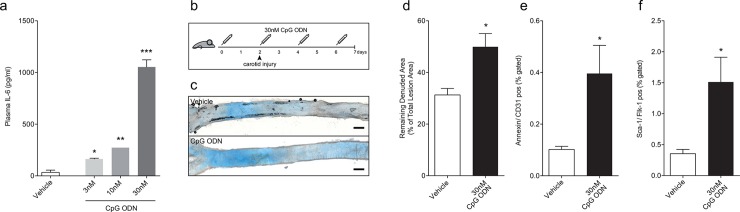
CpG ODN stimulation in acute vascular injury.WT mice were injected with PBS (n = 4) or 3-30nM CpG ODN (n = 2) i.v., respectively. Activation of TLR9 with 30nM CpG ODN led to the highest plasma IL-6 concentrations in mice compared to vehicle controls (a). For the acute injury, WT mice (n = 12–13) were subjected to an electric denudation of the left carotid artery and received repetitive injections of 30nM CpG ODN or vehicle over 7 days (b). Reendothelialization was greatly impaired in TLR9-stimulated mice compared to vehicle controls (c, representative Evan’s blue stained photomicrograph; and d, quantitative). The number of circulating EMPs (e, n = 5) and the number of circulating sca-1/flk-1 positive cells (f, n = 5) were significantly increased in ODN treated mice. Gating strategy for FACS analysis is shown in S3 Fig. Data are presented as mean±SEM. Statistical analysis was performed using 2-tailed, unpaired students t-test. Scale bar 200μm in c. *p<0.05, **p<0.001, ***p<0.0001.